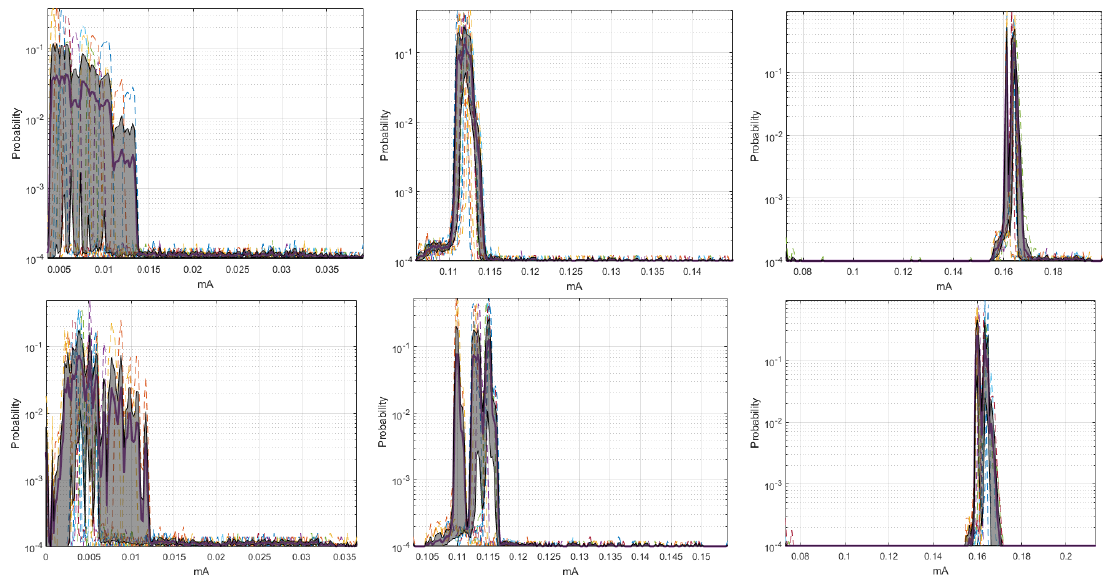
Figure 4. CI of pdf with distinctive characteristics for DigiMesh network. From left to right: Coordinator Node, Node 1, and Node 4. ( Top ) At 19,200 bauds; and ( Bottom ) at 57,600 bauds.